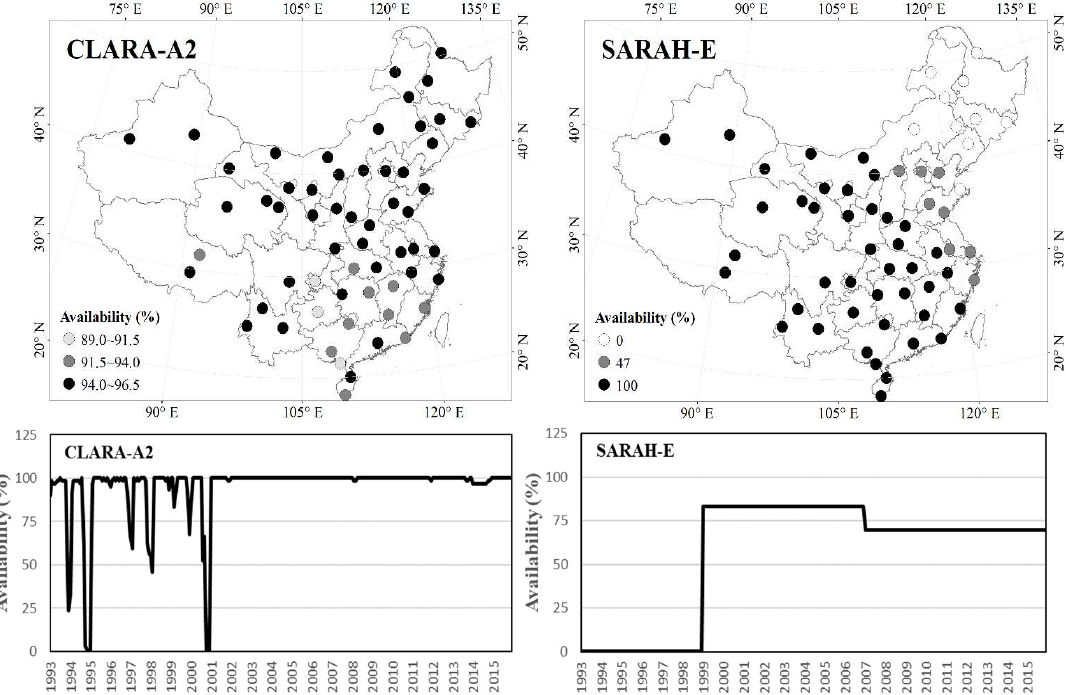
Figure 3. Availability (%) of the monthly SSR (Surface Solar Radiation) records in the CLARA-A2 and SARAH-E datasets in space (upper panels) (for the selected 59 stations across China) and time (from 1993 to 2015) (lower panels).